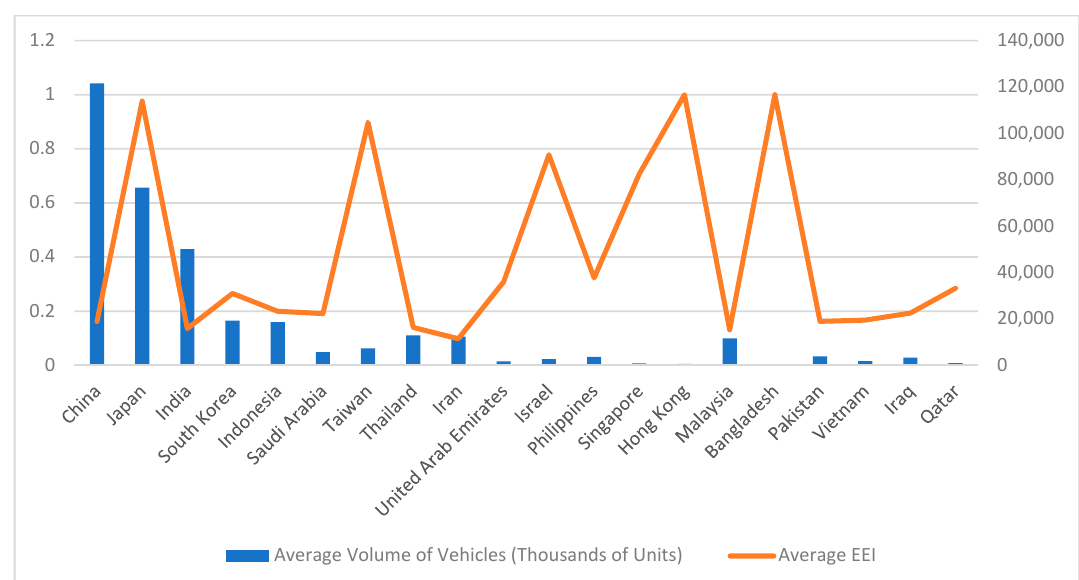
Figure 4. Comparison between the average EEI and the average Volume of Vehicles. Source: authors’ estimation.